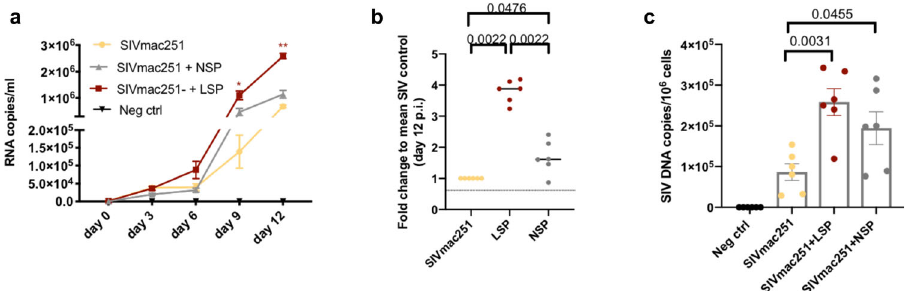
Fig. 4 Increased SIVmac251 replication in sigmoid tissue explants is associated with seminal plasma cytokine content. Sigmoid colon explants were infected with SIVmac251 with or without a pooled NSP or LSP. a Kinetics of SIVmac251 replication in explants treated with virus alone (yellow line), virus plus 25% LSP (red line), or virus plus 25% NSP (gray line). Culture medium was used as negative control. Virus replication was evaluated in the basal supernatant as viral RNA copies/ml. b Fold change increase in cumulative viral production by each ( n = 6) biopsy measured by RT-PCR compared to the mean positive control value (explant exposed to SIVmac251 alone, mean of 6 values). c SIV DNA quanti fi cation in explants infected in the presence or